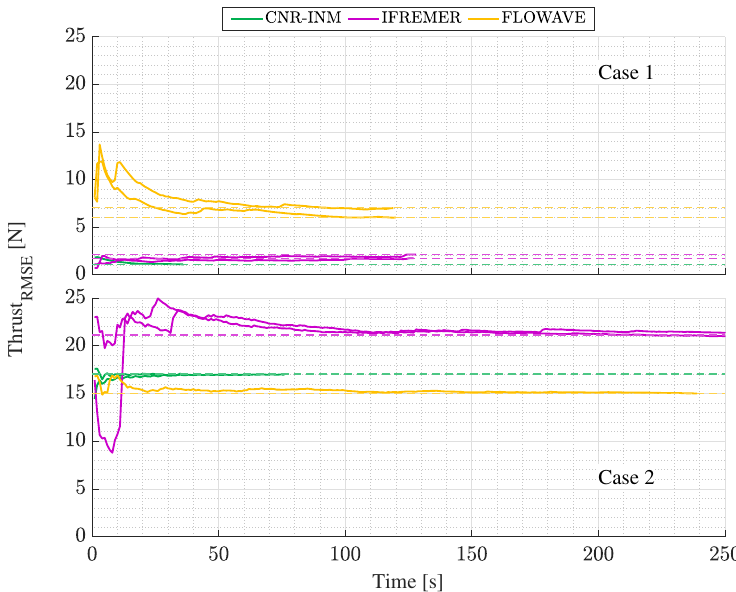
Figure 17. Stabilisation of the thrust RMSE at TSR = 4 for case 1 ( top ) and 2 ( bottom ) at all facilities. Dashed lines are the RMSE value of the whole time series; same-colour curves are repeat tests when available.